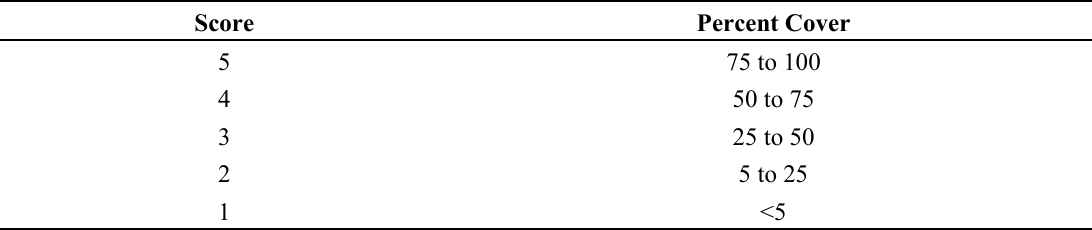
Table 1. Definition of Braun Blanquet abundance scores used to characterize seagrass cover in-situ